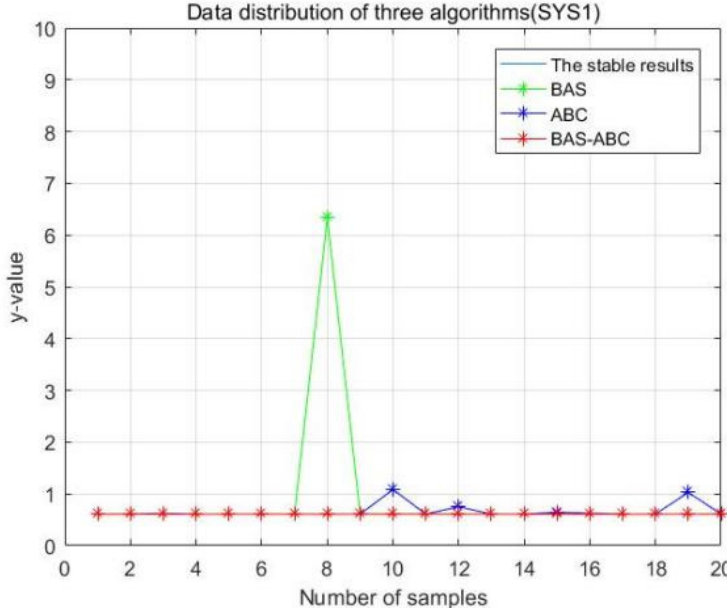
Figure 13. Data distribution-20 of three algorithms (SYS1).